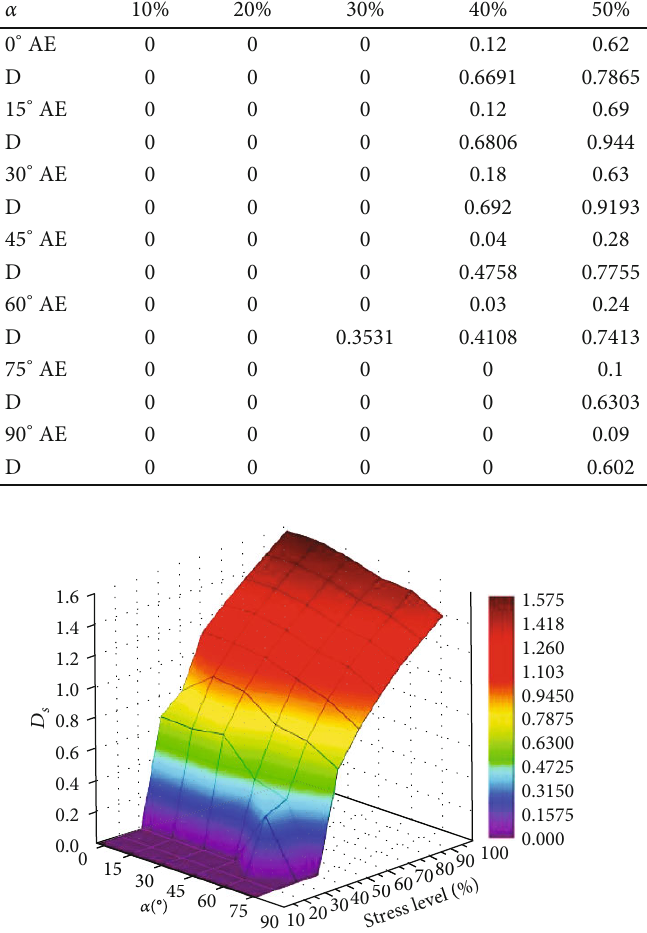
Figure 19: Relationship between stress level, azimuth, and fractal